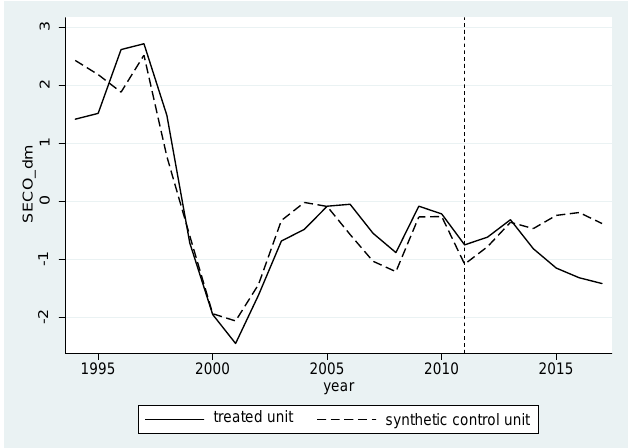
Figure 13. Outcome specification